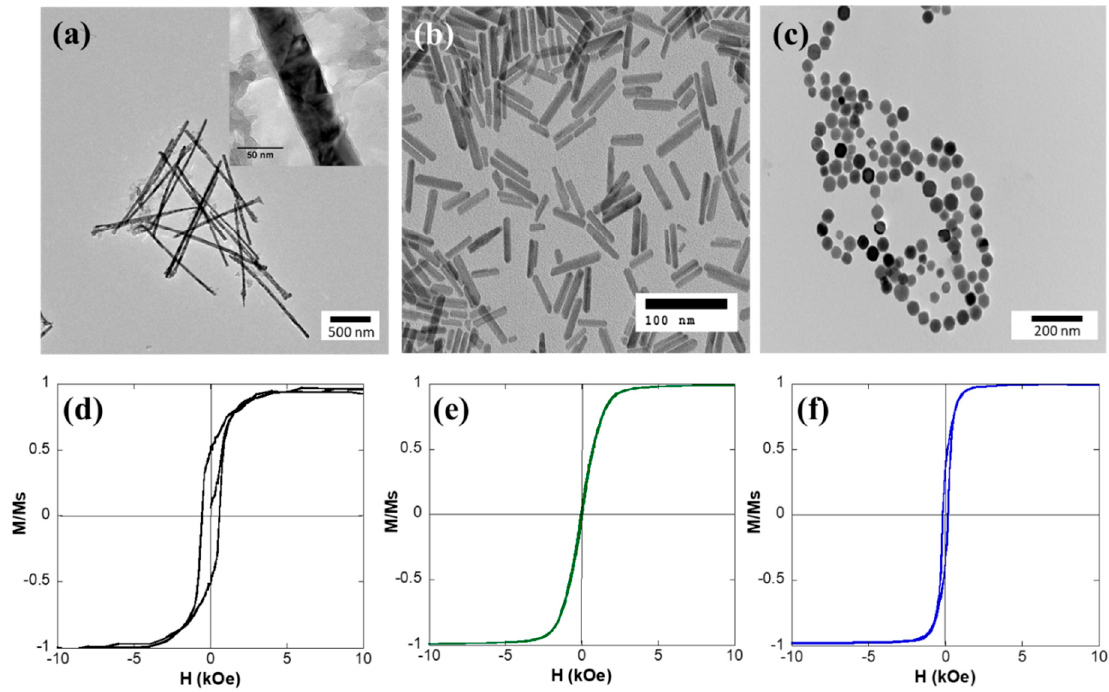
Figure 1. TEM images of ( a ) Ni MNWs, ( b ) Fe 3 O 4 NRs, and ( c ) MGs. The inset to ( a ) shows a zoomed picture of an Ni MNW. M-H loops measured at 300 K for ( d ) Ni MNWs, ( e ) Fe 3 O 4 nanorods, and ( f ) Fe 3 O 4 magnetosomes. Table 1. Dimensions, composition, coercivity ( H c ), normalized remanence ( M r / M s ), and saturation magnetization ( M s ) of Ni magnetic nanowires (MNWs), Fe 3 O 4 nanorods (NRs), and magnetosomes (MGs) measured at 300 K. The error corresponds with the standard deviation of the size